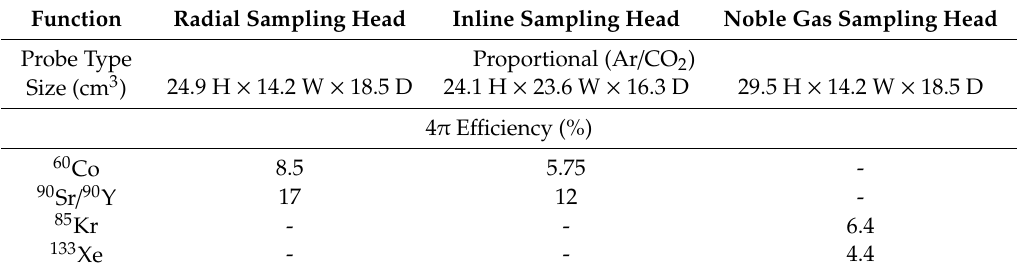
Figure 13. AMS-4 beta air monitor [77]. Table 9. AMS-4 specifications.